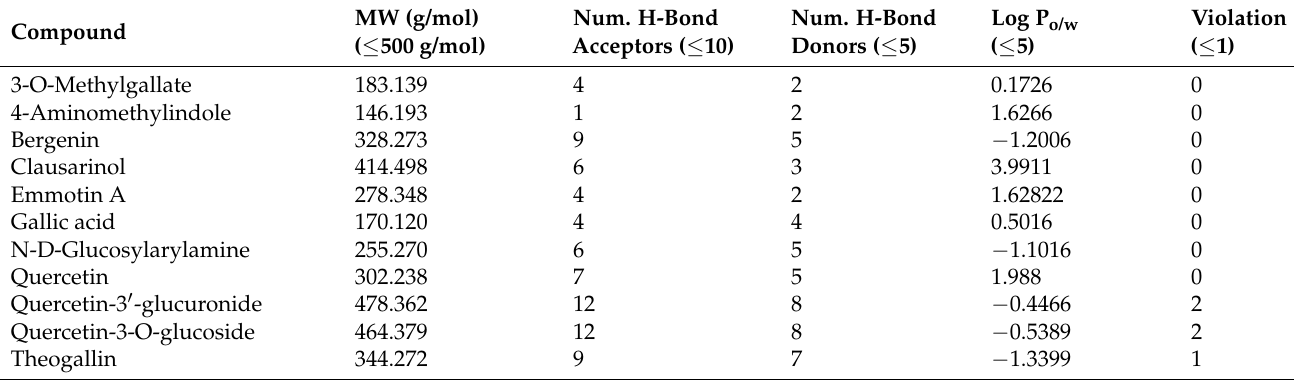
Figure 11. Diagrams represent protein–ligand interactions. Schematics of amino acid interactions of BACE1 and candidate ligands: ( A ) quercetin, ( B ) quercetin-3′-glucuronide, ( C ) quercetin-3-O-glucoside, ( D ) clausarinol, and ( E ) theogallin. Green dashes indicate hydrogen bonds. Pink dashes indicate hydrophobic bonds. Orange dash indicates electrostatic bond. Table 3. The physiochemical properties of CM-phytoconstituents based on Lipinski’s rule of